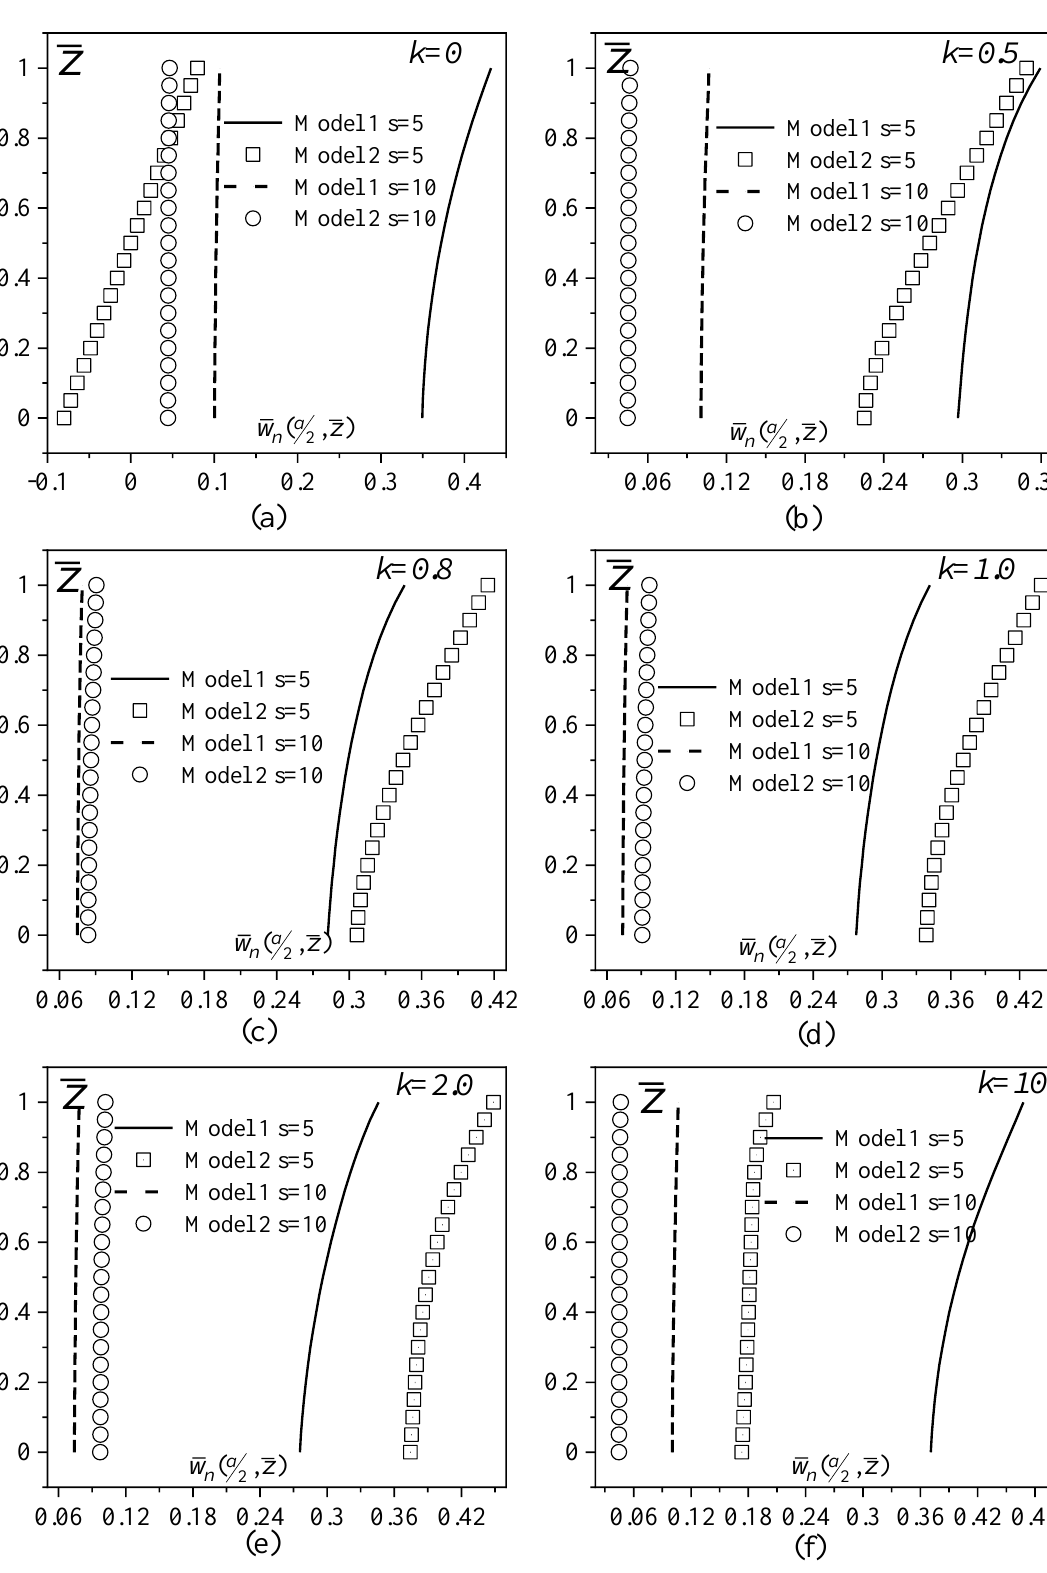
w ) for various graded FG n